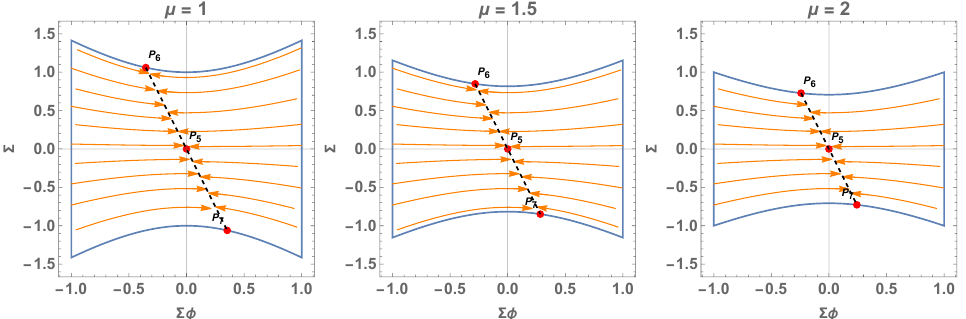
Figure 2. Phase plot for System (68)–(69) for (cid:101) = − 1 and different values of µ . The dashed black line corresponds to L 1 .